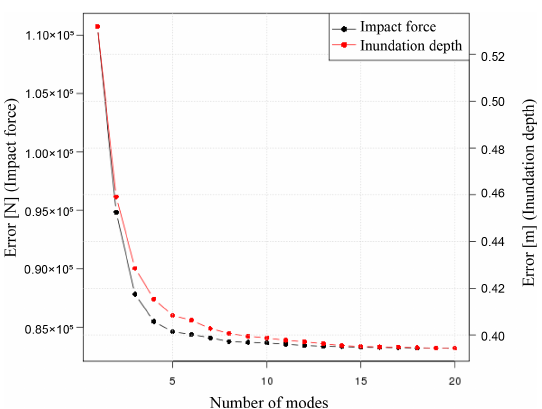
Figure 13. The root mean squared error for the results obtained from the numerical analysis and those of the surrogate models for each mode.